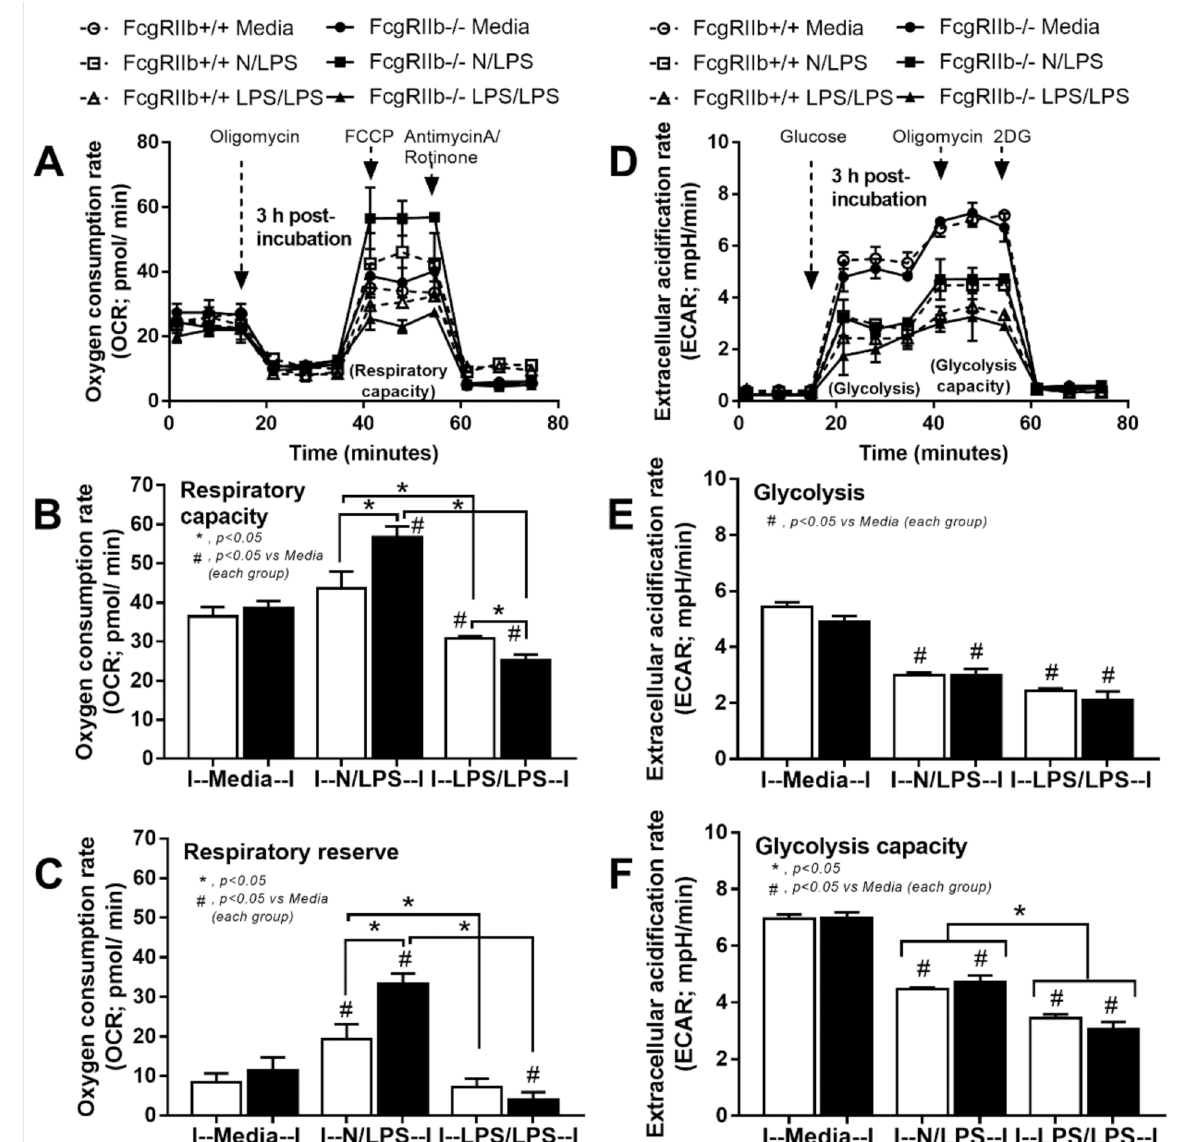
Figure 9. The extracellular flux analysis pattern of macrophages from FcgRIIb-/- lupus mice and wild-type (FcgRIIb+/+) mice after 3 h of the incubation by media control (Media), a single LPS stimulation (N/LPS), and the twice LPS stimulation (LPS/LPS) as demonstrated by mitochondrial stress test (a pattern of oxygen consumption rate, respiratory capacity, and respiratory reserve) ( A–C ) and glycolysis stress test (a pattern of extracellular acidification rate, glycolysis and glycolysis capacity) ( D–F ). Independent triplicate experiments were performed. 2-DG, 2-Deoxy-D-glucose; FCCP, carbonyl cyanide-4- (trifluoromethoxy)